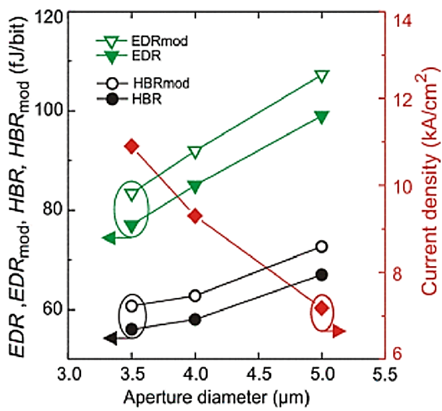
Figure 2. Schematic cross-section of oxide-confined VCSELs [43].